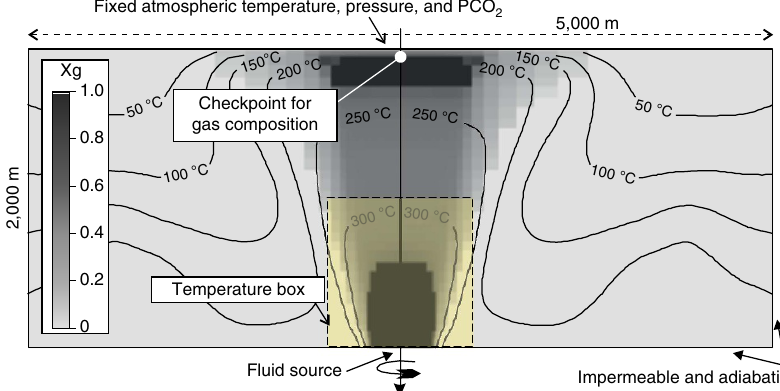
Figure 4 | Computational domain of the TOUGH2 simulations. The rock physical properties were homogeneous (porosity ¼ 0.2; thermal capacity ¼ 1,000Jkg (cid:2) 1 (cid:2) C (cid:2) 1 ; density ¼ 2,000kgm (cid:2) 3 ; horizontal permeability ¼ 10 (cid:2) 14 m 2 ; vertical permeability ¼ 1.5 (cid:3) 10 (cid:2) 14 m 2 ; and thermal conductivity ¼ 2.8Wm (cid:2) 1 (cid:2) C (cid:2) 1 ). The temperature and the volumetric gas fraction Xg (different shades of gray) refer to steady-state conditions. The ‘checkpoint for gas composition’ is the zone where the simulated CO 2 /H 2 O is compared with the measured one (see Methods). The ‘Temperature box’ (yellow rectangle above the injection zone) is the region where the average temperature is calculated during the simulations (see Figs 5 and 6 and Supplementary Fig.